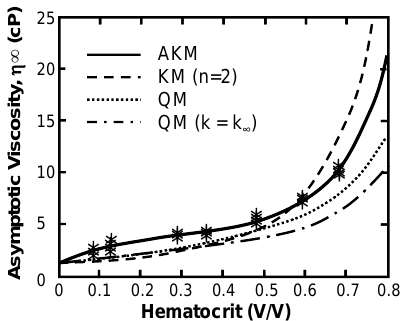
Figure 2. Comparison of regression of asymptotic viscosity vs. hematocrit with the Asymptotic Krieger model (AKM), Krieger model ( n = 2), the Quemada model, and the asymptotic Quemada model ( k = k ∞ ) to the experimental data of Brooks et al. (asterisks) [49]. (Shear rate > 100 s −1 ). Table 3. The best fit parameters for the three modified Krieger models with 95% confidence intervals for the parameters as determined from Monte Carlo simulation. Model Parameter